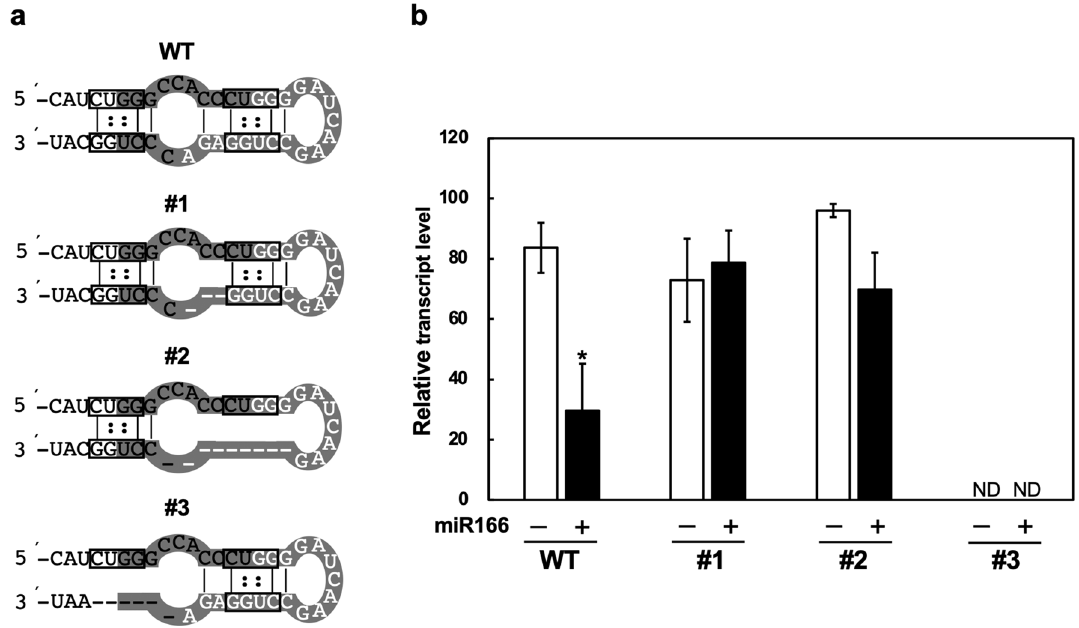
Figure 3. Effects of RDD1 mutations on the deletion of the 32-bp region from the RT-PCR products by adding synthetic miR166. ( a ) Inferred secondary structures of the 32-bp region in the RDD1 transcripts of the wild- type (WT) and R1 -Cas #1–3 plants. Nucleotide sequences corresponding to the 32-bp region are shaded, and those of the miR166 recognition site are denoted by white letters. 5’-CUGG-3’ sequences are boxed and G–U base pairs are denoted by double dots. ( b ) RT-PCR amplification of RDD1 in addition to synthetic miR166. Total RNAs from the shoots of the WT and R1 -Cas #1–3 plants at the 4-leaf stage were reverse-transcribed in the absence (−) or presence (+) of synthetic miR166 RNA. The plants were grown in a low concentration hydroponic nutrient solution under normal conditions and harvested 2 h after the onset of illumination. The transcript levels are normalized to those of RUBQ2 , and the highest transcript level is defined as 100. Data are presented as the average ± standard error of the mean ( n = 3). An asterisk indicates a significant difference relative to the transcript level in the absence of synthetic miR166 based on the Student’s t -test (* p < 0.05). ND, RT-PCR products could not be amplified due to a partial deletion of the annealing site for the − 32-bp primer (see Fig.